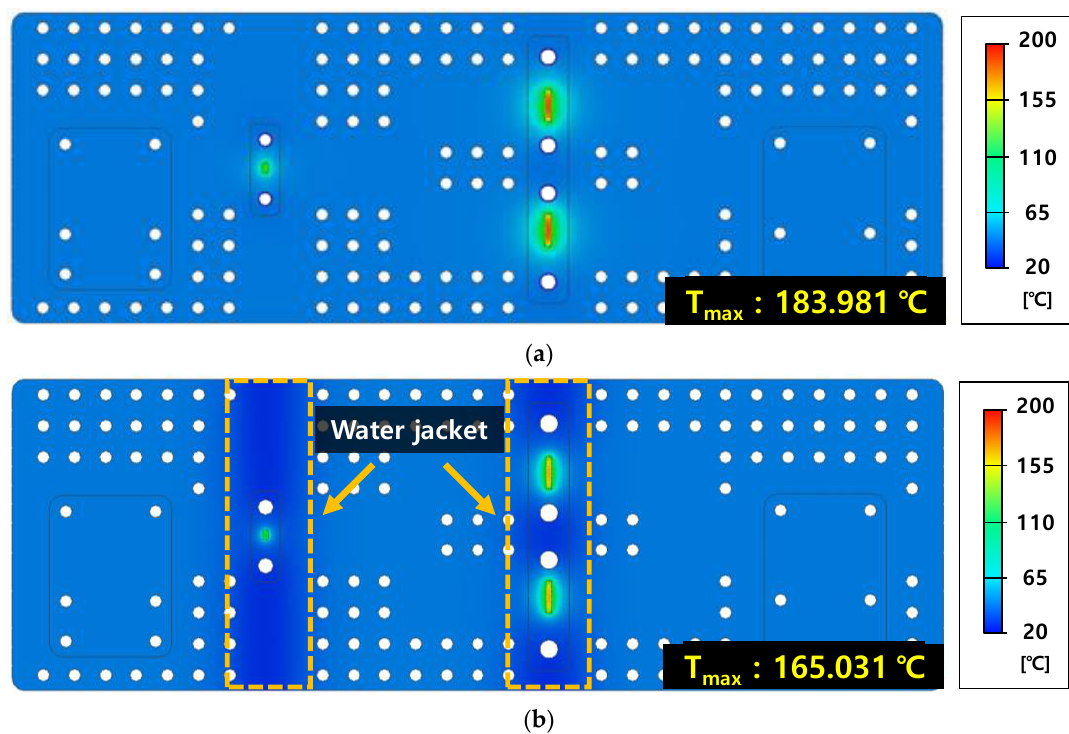
Figure 6. Thermal simulation results: the proposed module ( a ) without and ( b ) with water jacket implementation.